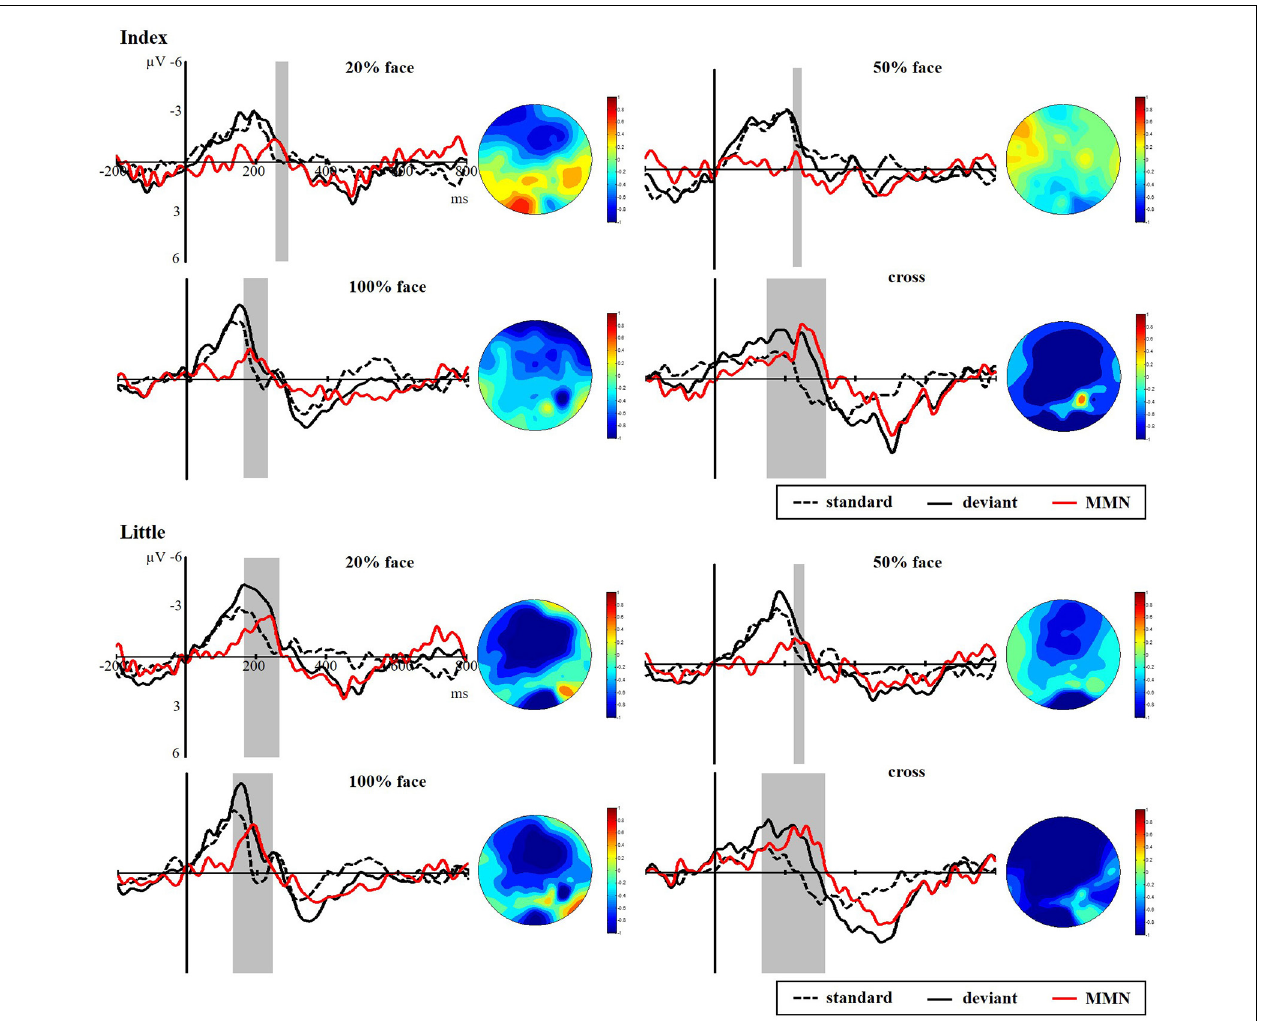
FIGURE 5 | Grand average ERPs of standard (dotted line) and deviant (solid line) stimuli at the FC4 electrode site. Somatosensory mismatch negativity (sMMN; red line) obtained by subtracting the waveforms of the standard stimuli from waveforms of the deviant stimuli. The gray area superimposes on the waveform represent the time window of sMMN, showing the significant differences between the standard and deviant stimuli as revealed by the point-wise paired t -tests ( p < 0.05). The scalp topographic distributions are shown beside the waveforms of ERPs for time windows of 100–300